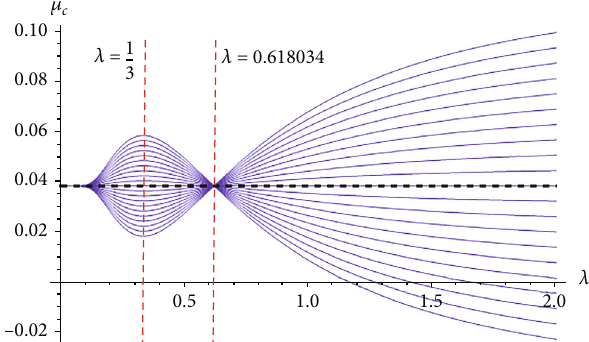
λ for di ff erent values of α (the dashed line Figure 4: μ c versus represents μ c for α = 0